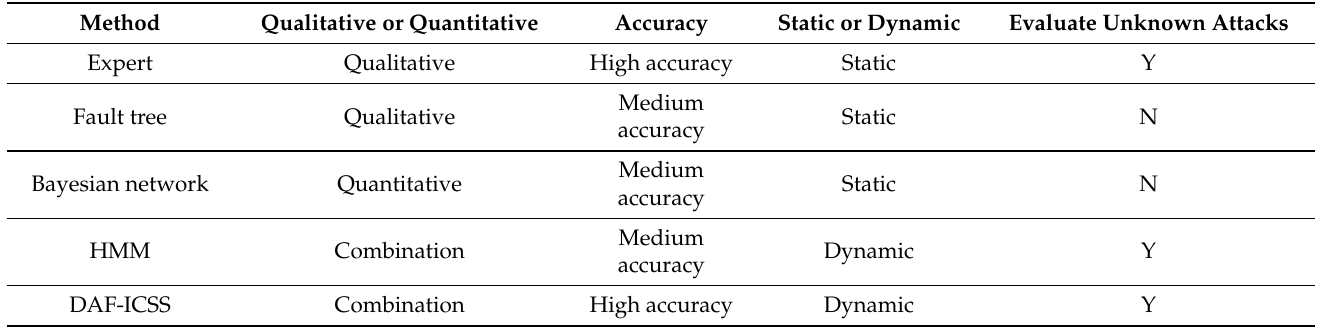
Table 11. The comparison of some security assessment methods in